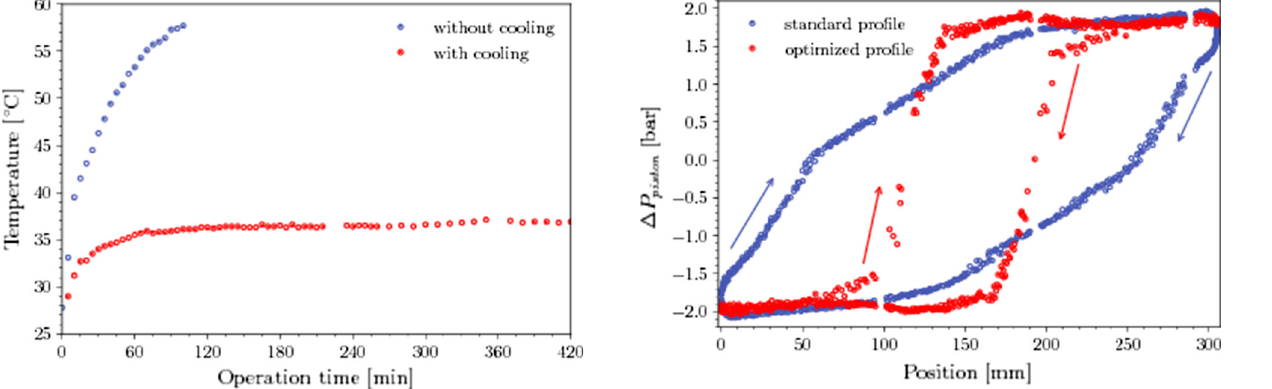
Due to the fact that the pressure rises slowly over the pis- ton stroke, maintaining a constant Δ P piston is non